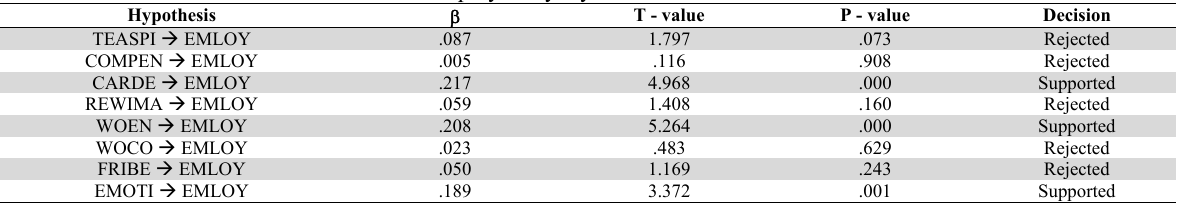
Model summary: R 2 =.463